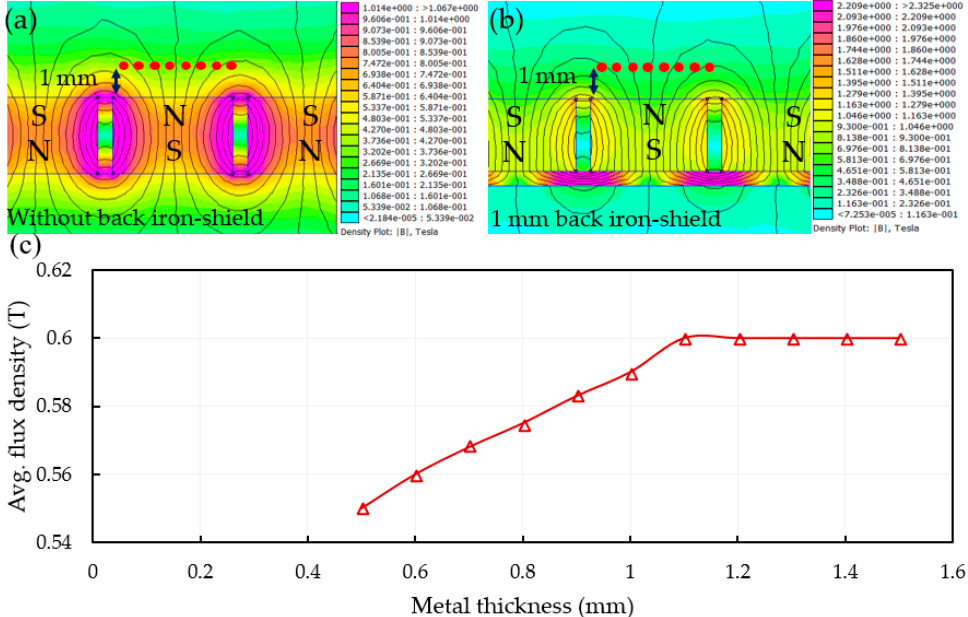
Figure 2. Finite element analysis of the magnetic structures to determine the magnetic flux densities: ( a ) without back-iron shield, ( b ) with a 1 mm-thick back iron-shield, and ( c ) average flux density vs. metal (back-iron) thickness.